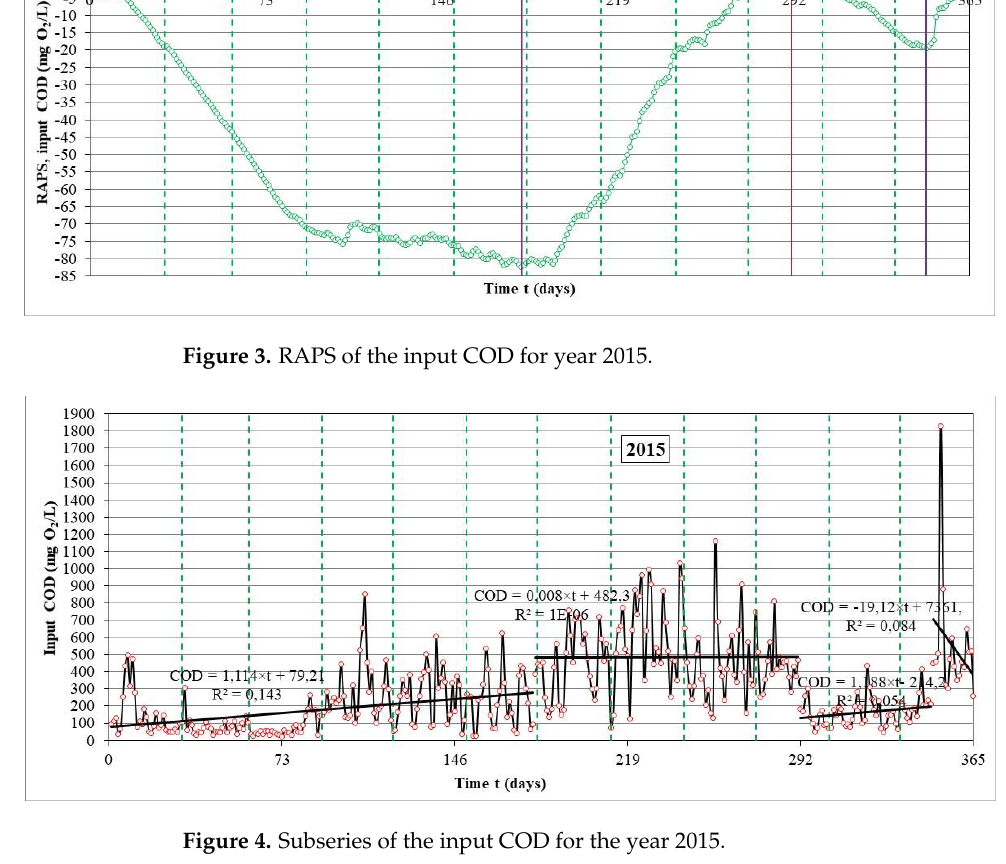
Figure 4. Subseries of the input COD for the year 2015.